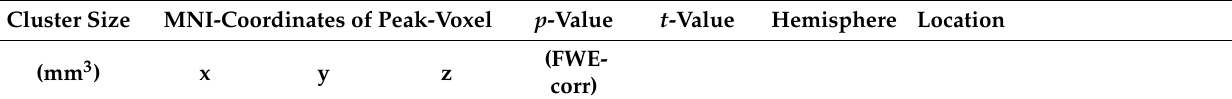
Table 3. Significant clusters of brain activity of introspection relative to object feature identification irrespective of mismatch and match conditions (Figure 3, cyan region) and of introspection-specific mismatch as compared with object feature identification-related mismatch (Figure 3, magenta region). The locations of local maxima were defined according to Mai et al. [42].